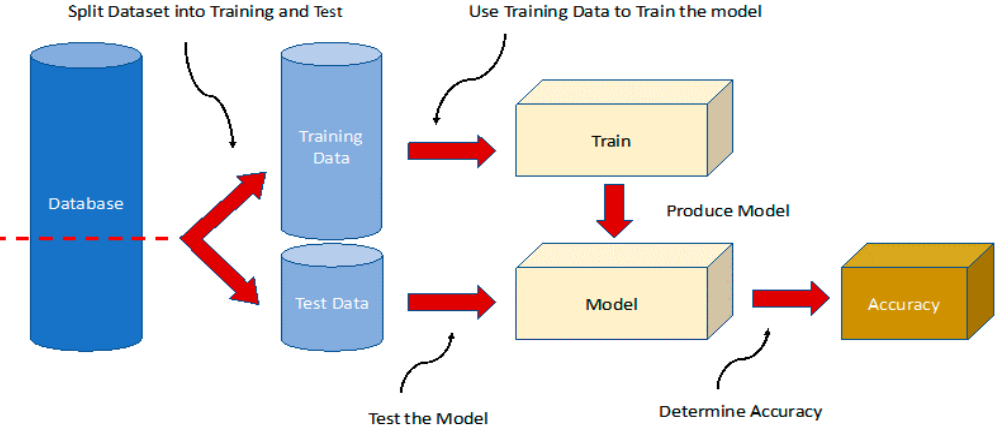
Figure 2. Training and validation scheme for machine learning methods. The database is split, and 70% of the data are used for training and validation of the method and 30% for testing. The model is trained with a training set and scored on the test set (metrics), and then the process is repeated k-times. After this training, pattern discrimination is then tested in a different subset of patients (test set, 30% of the database). The whole process is then repeated until the learning stabilizes and stops improving. The results presented in this study are obtained from the evaluation of this subset.